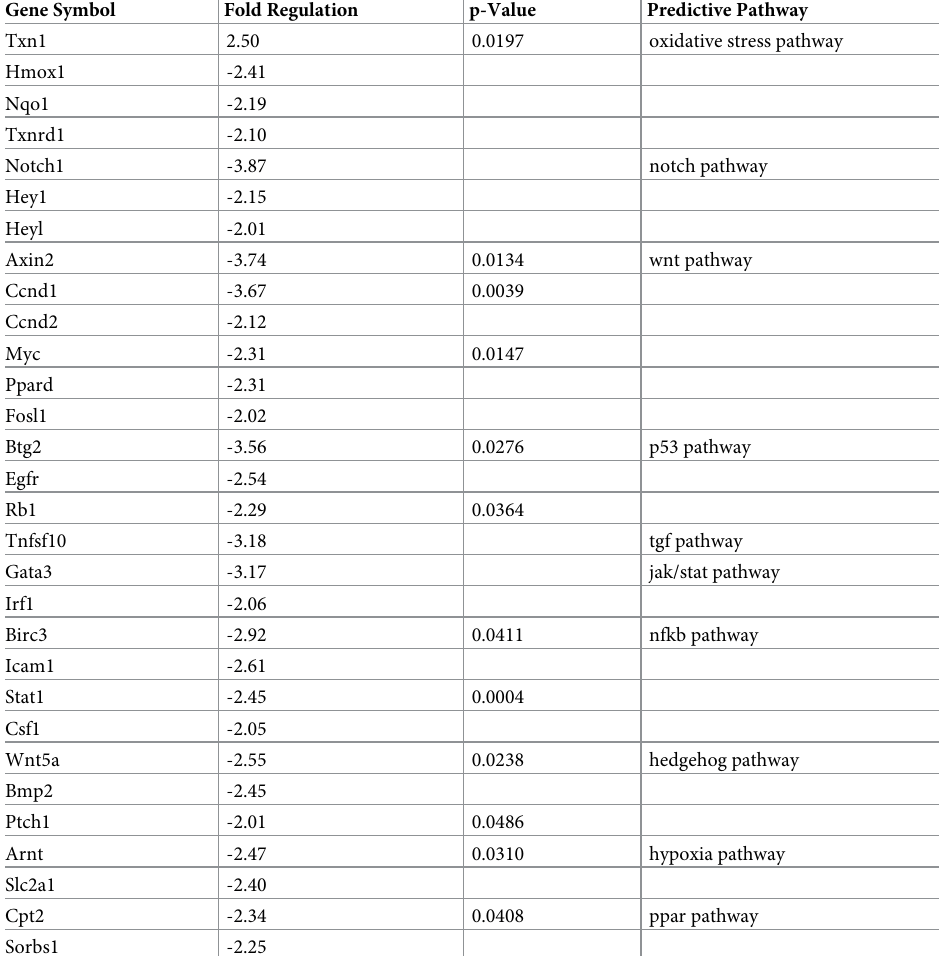
Table 2. Genes expressed following 532 nm laser exposure at moderate irradiance of 0.25 W/cm 2 . Gene